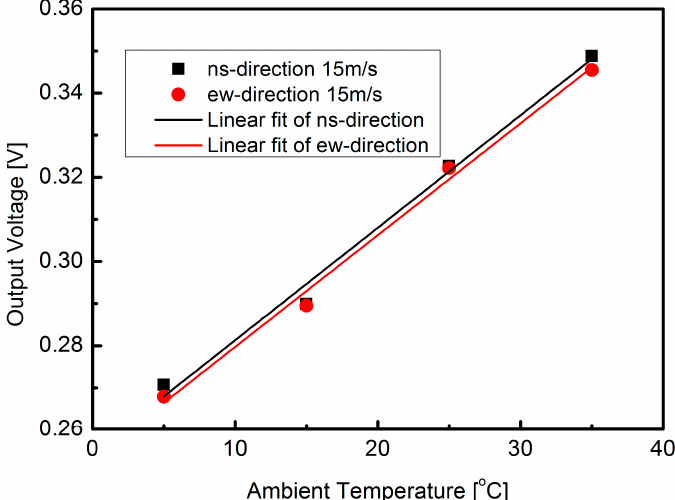
Figure 10. The output voltages in north-west and east-west directions have the ambient temperature when the wind speed is 15 m/s.